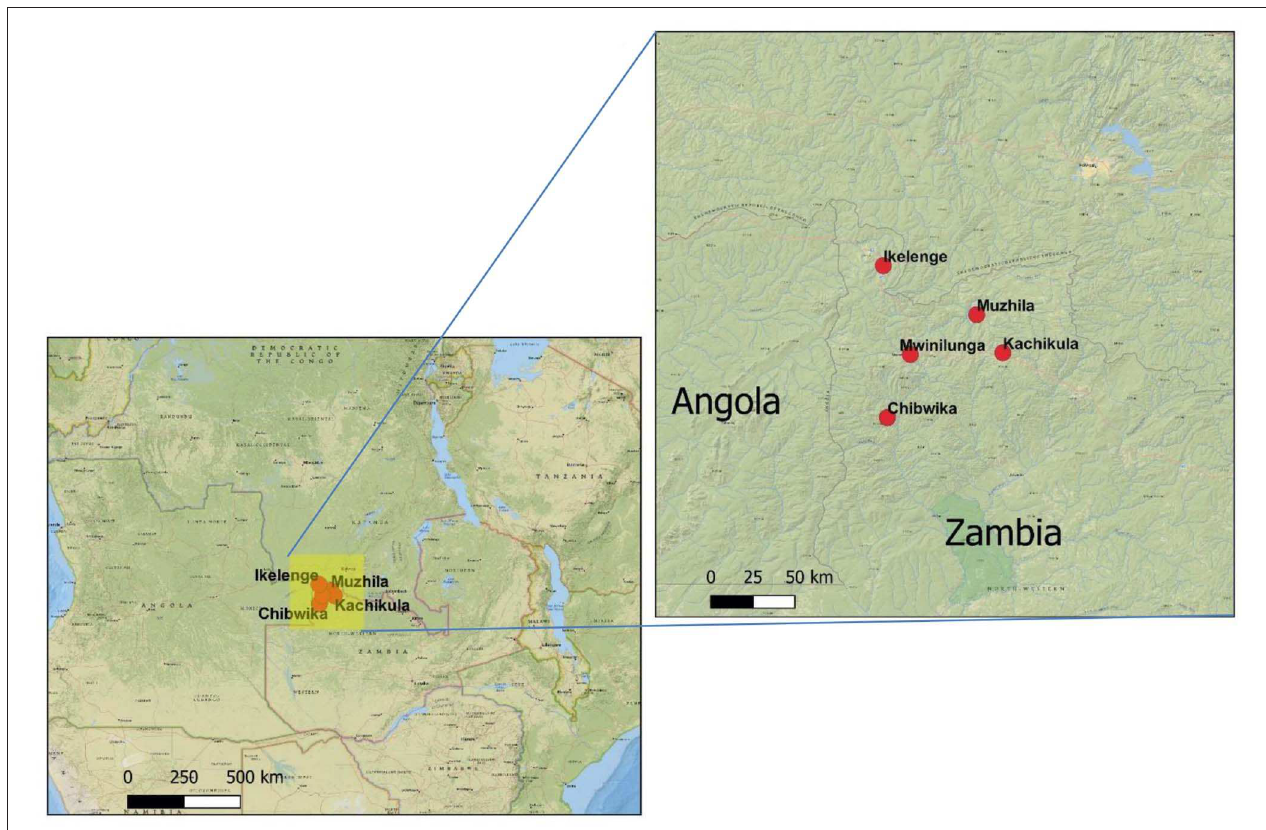
FIGURE 1 | Research sites in Mwinilunga, North-Western Province, Zambia. Source of map: Map created in QGIS using GPS points collected by author and basemap is ESRI National Geographic sourced from